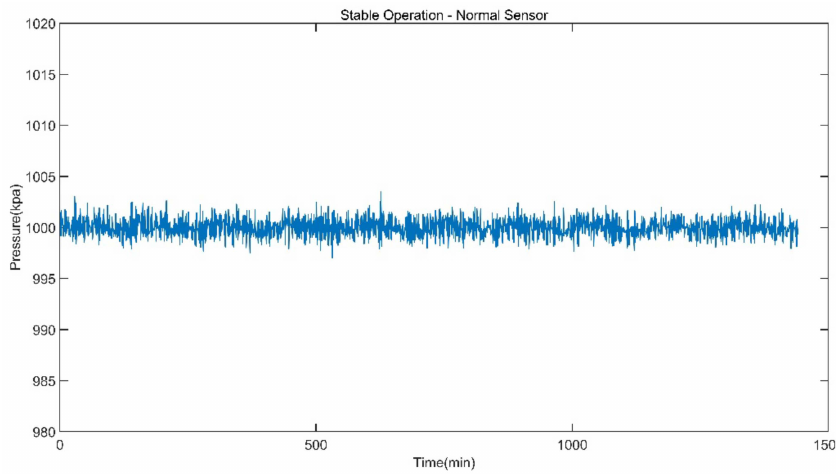
Figure 5. Reheat Steam Pressure of Stable Operation.